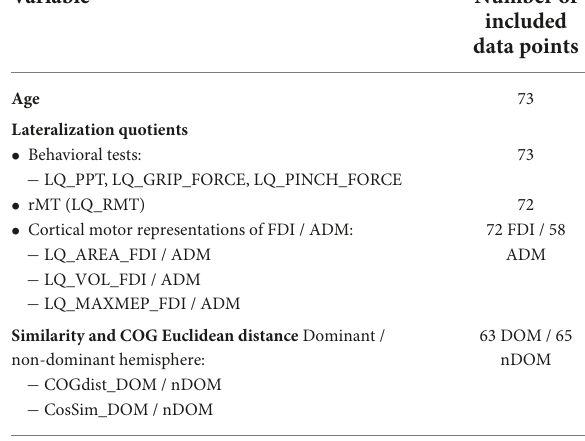
TABLE 3 Number of included data points for each variable included in the